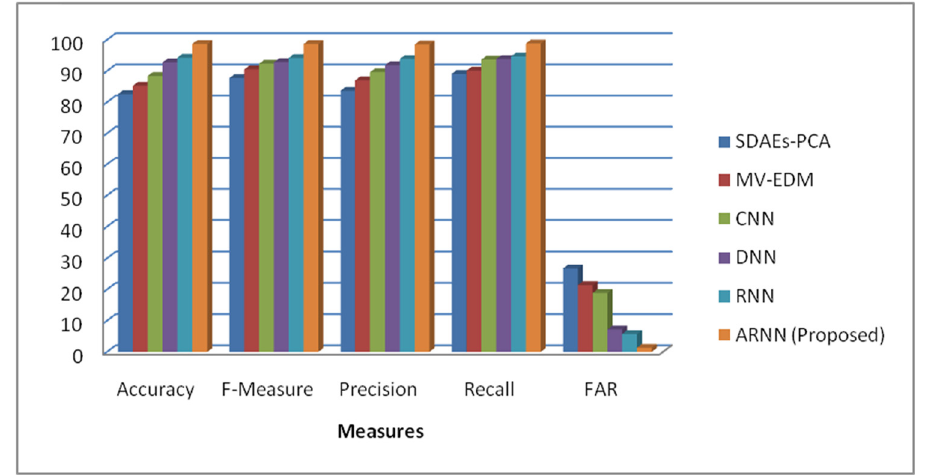
Figure 8: Performance analysis of